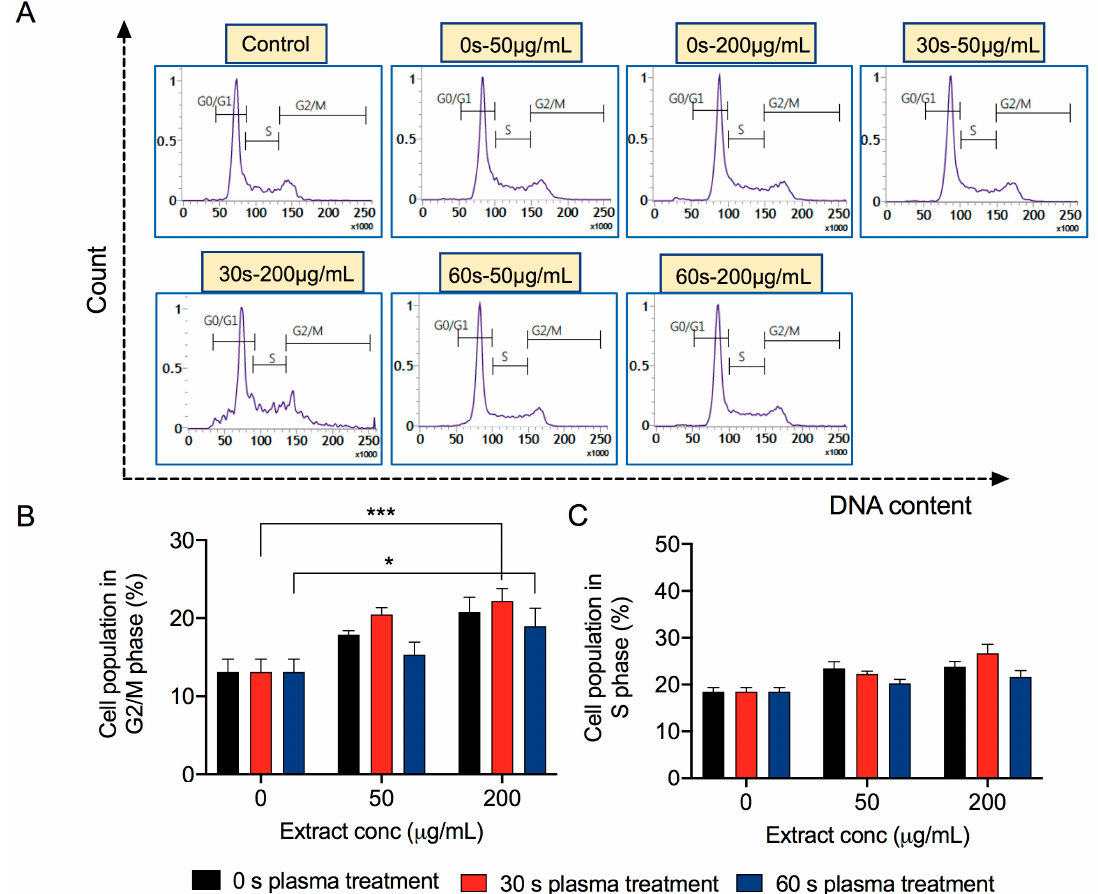
Figure 6. Cell cycle arrest is associated with cancer cell death. ( A – C ) Flow cytometry analysis of MCF7 breast cancer cells treated with extracts prepared from 0 s (untreated), 30 and 60 s plasma-treated mushrooms at 50 and 200 µg mL –1 using PI/RNase A, after 24 h post-incubation. Representative graph shows percentage of cell population in G2/M and S phase. * p < 0.05, ** p < 0.01, and *** p < 0.001.